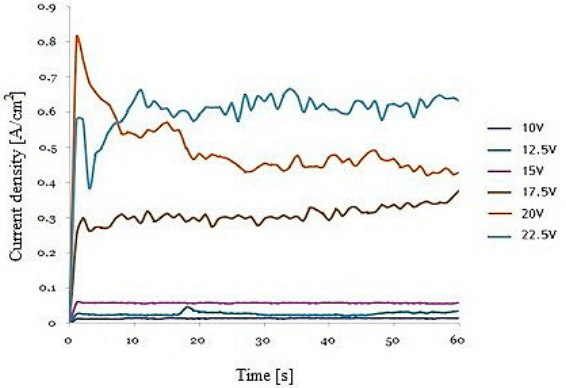
Figure 1. Current density vs. time for the second step of FeAl 3 self-organized anodization in 20 wt% H 2 SO 4 at 0 °C.